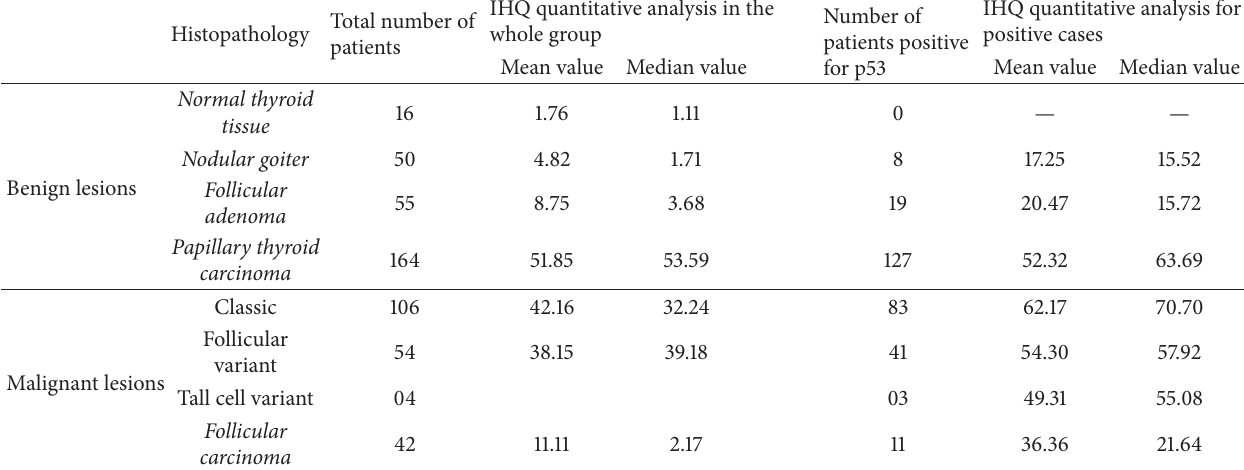
Table 1: Immunohistochemical (IHC) expression of p53 protein using automated cellular imaging system ACIS-III quantitative analysis, according to histopathological